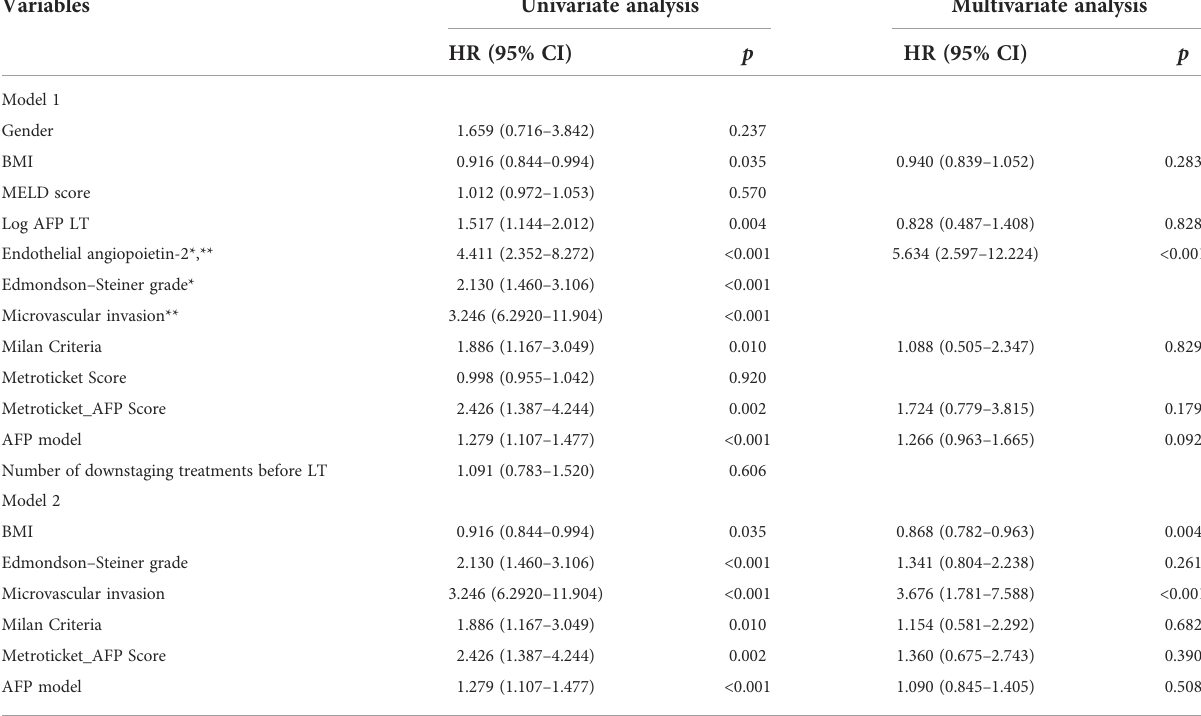
TABLE 1 Univariate and multivariate analysis results for recurrence of HCC after LT in the training